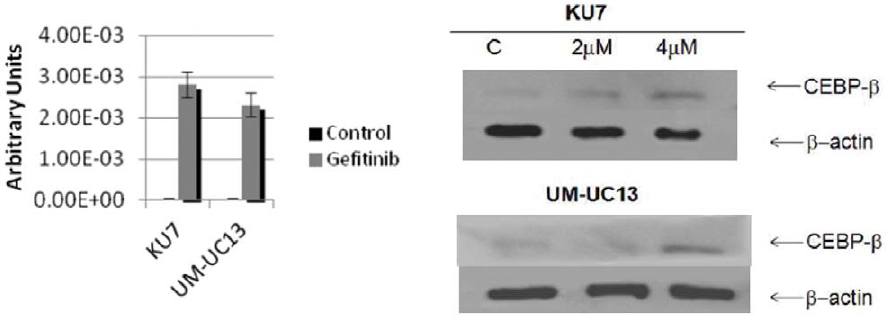
Figure 9. mRNA expression of CEBP b after treatment with gefitinib. (A) RT-PCR of cells treated with gefitinib (B) Western blot of CEBP b expression in KU-7 and UM-UC-13 cell lines in response to different concentrations of